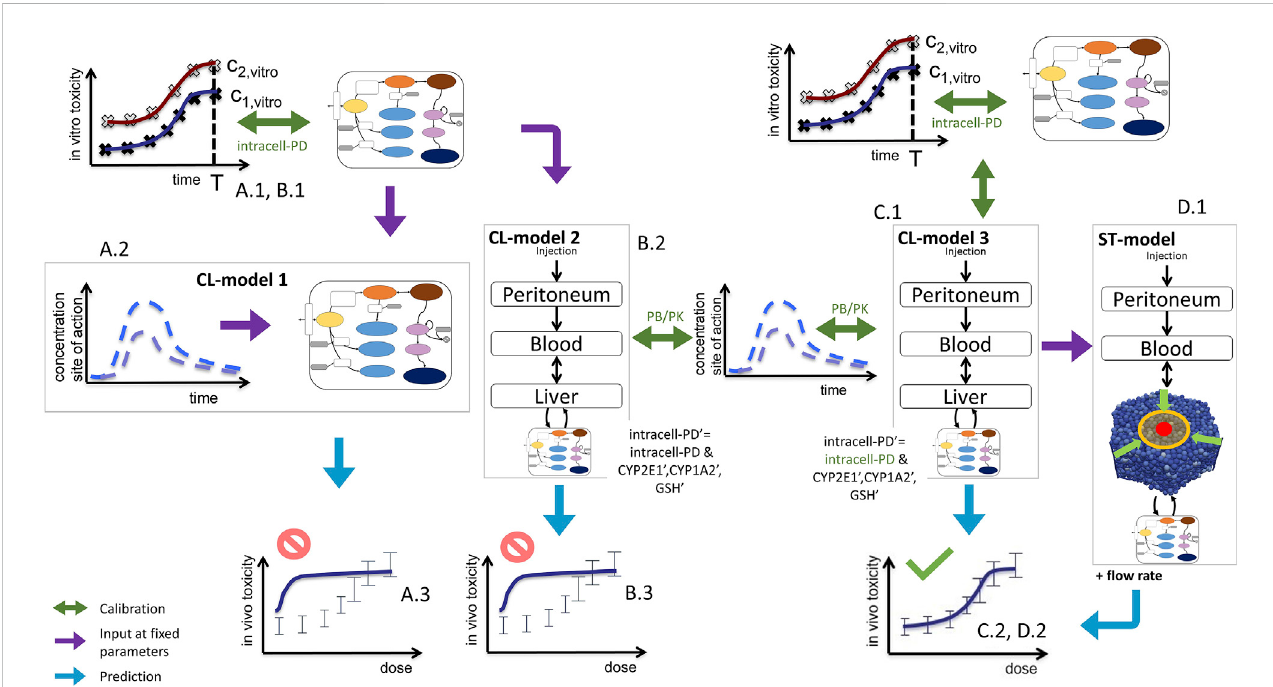
FIGURE 3 Sketch ofmodel-based extrapolationstrategies, detailing Figure 1VI.Fortheexplanation, seetext. Green text indicates thoseparameters that were fi tted in the respective modeling step. The prime in (B) 2 and (C) 1 indicate parameters used for the in vivo